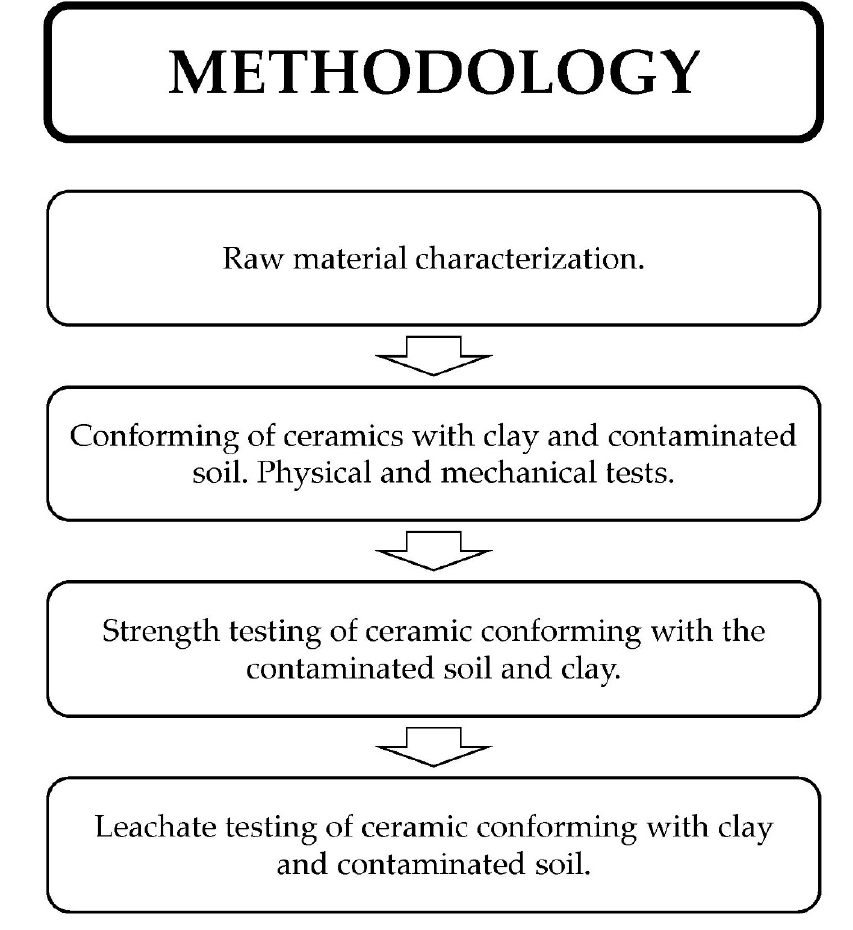
Figure 2. Flow diagram of the different blocks developed in the methodology.